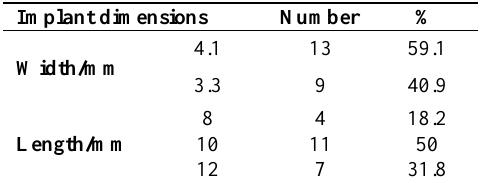
Table 1: The Distribution of DIs according to the dimensions Implant dimensions